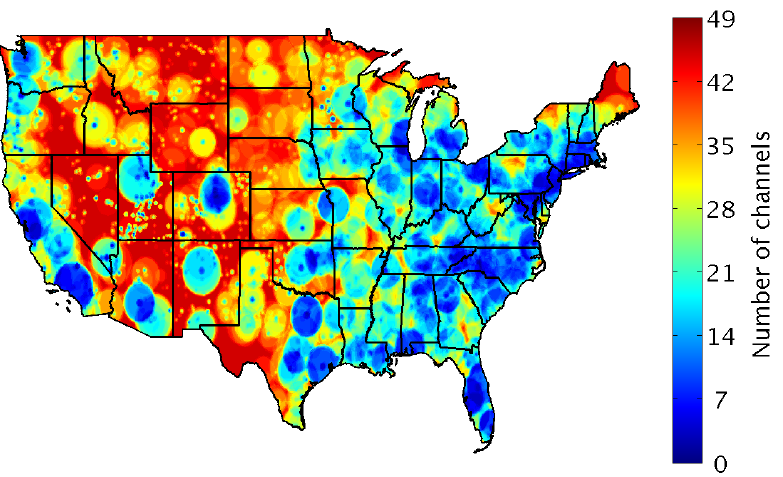
Figure 13. Amount of 6 MHz TV channels available for SUs in the United States in 2015. Adapted from the work in